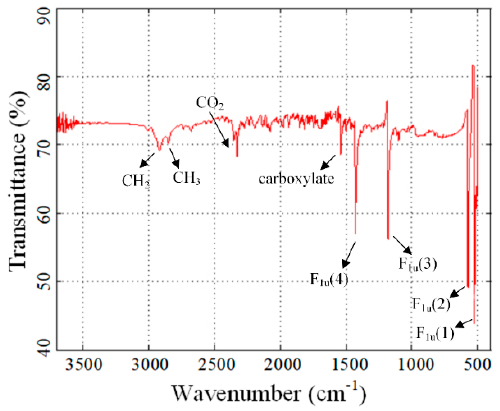
Figure 1. Infrared spectroscopy of the C 60 nanoparticles.